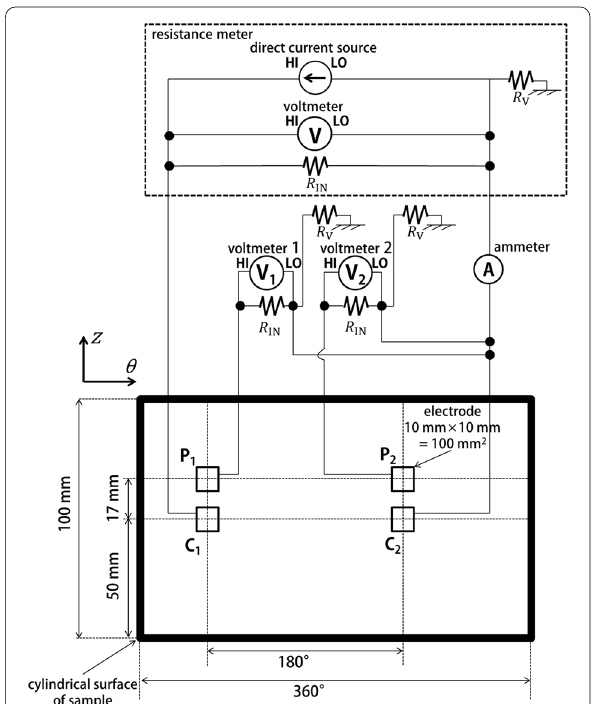
Fig. 4 Measurement scheme. z and θ are coordinates defined in Fig. 2a. The dotted square is a resistance meter, R IN is input resistance, R V is insulation resistance between the negative terminal and chassis ground, HI labels positive terminals, LO labels negative terminals, C 1 and C 2 are current electrodes, and P 1 and P 2 are potential electrodes. The electrometer (Model 6514, Keithley, Cleveland, Ohio, US.) in resistance measurement mode injects known direct constant current, measures the voltage caused by injected current, and obtains resistance. An ammeter (Model 3458A, Keysight; Santa Rosa, California, USA) was placed in order to monitor the amount of injected current. Electrometers (Model 6514, Keithley, Cleveland, Ohio, US.) with R IN 200 TΩ acted as the resistance meter and the =